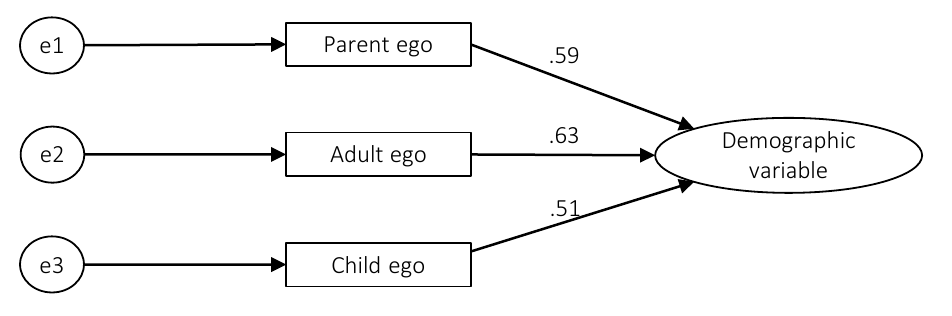
Figure 4. Structure equation model of ego states impacts on demographic